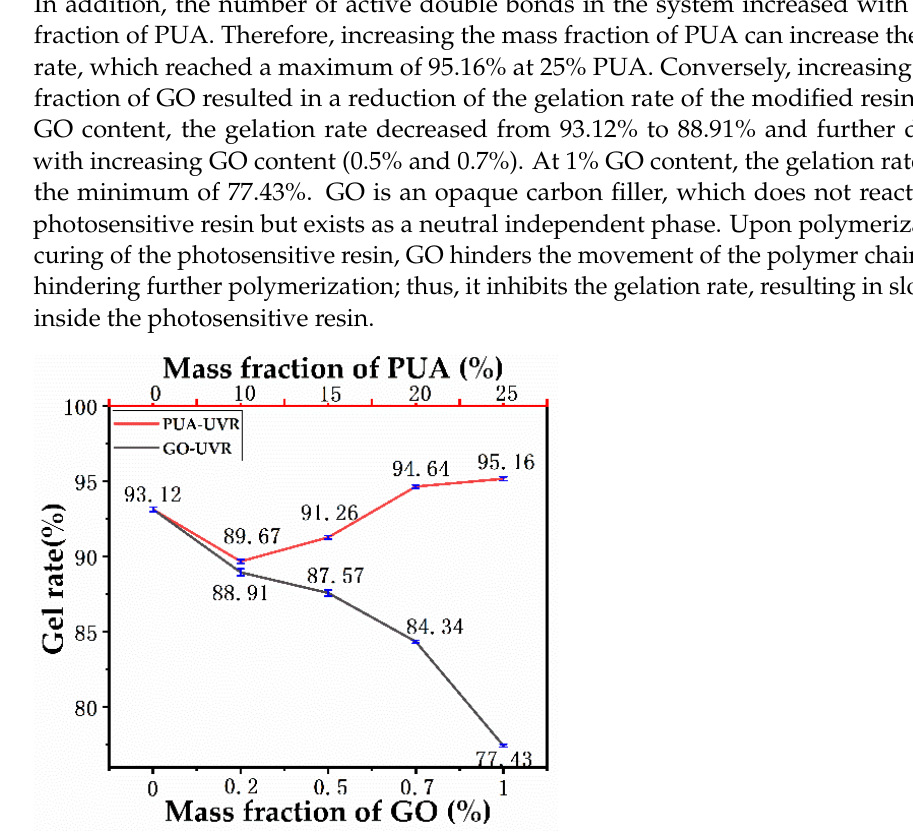
Figure 9. Viscosity relation of ( a ) free − radical/cationic hybrid, ( b ) polyurethane acrylates (20%) modified, and ( c ) graphene oxide (0.7%) modified photosensitive resins. 4. Conclusions A UV curable free − radical/cationic hybrid photosensitive resin was prepared by the polymerization of free radical and cationic oligomers in the presence of active diluents and photoinitiators. An optimal acrylate to epoxy resin ratio of 1:1 was determined. The tensile strength of the resin was significantly improved by the addition of PUA, reaching the maximum of 36.89 MPa at a PUA content of 20%. Moreover, increasing the mass